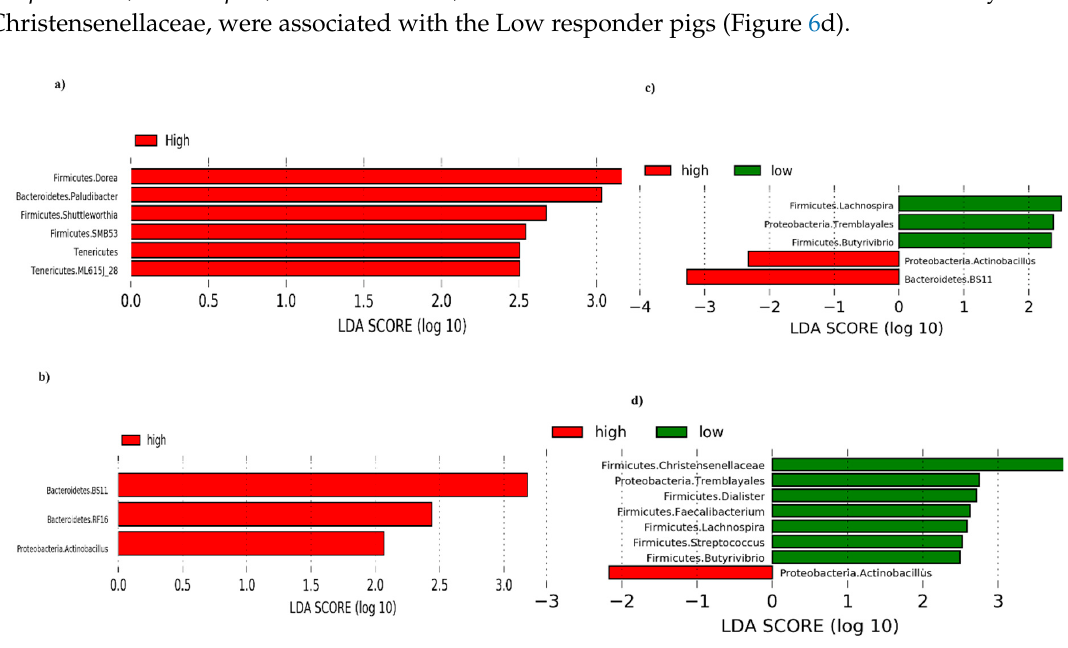
Figure 6. Discriminant analysis of pre-vaccination taxa (at genus level) in High and Low responder pigs selected based on antibody titers determined at different time points. ( a ) Taxa that significantly discriminated between High and Low responder pigs selected based on antibody titers determined at 21 dpv. ( b ) Taxa that significantly discriminated between High and Low responder pigs selected based on antibody titers determined at 28 dpv. ( c ) Taxa that significantly discriminated between High and Low responder pigs selected based on antibody titers determined at 35 dpv. ( d ) Taxa that significantly discriminated between High and Low responder pigs selected based on antibody titers determined at 118 dpv. dpv = days post-vaccination. 3.4. Contrasted Antibody Response Was Not Accompanied by Significant Changes in Microbiota Composition at 21, 35, and 118 dpv No significant differences were observed between the High and Low responder pigs at 21, 35, and 118 dpv except, we found eight OTUs that were differentially abundant between the two groups at 21 dpv. Four of the differentially abundant OTUs were annotated to Prevotella , three were annotated to Treponema , and one was annotated to unclassified Bacteroidales. Of the eight OTUs, only one OTU annotated to Prevotella was abundant in the group of pigs classified as High, whereas the rest were abundant in the Low responder pigs. No other significant differences were observed. 4. Discussion The gut microbiota plays an important role in shaping mucosal and systemic immunity and protecting the host from pathogen expansion and invasion [5,6]. In this study, we used M. hyopneumoniae vaccination to study the potential of early gut microbiota at weaning in predicting future vaccine response, and to explore the dynamics of gut microbiota composition following vaccination. Previous studies in both human and mouse models have demonstrated the importance of commensal bacteria in immune responsiveness to infections in various ways, and to vaccines, such as influenza, polio, and cholera toxins [10,17,38,39]. The studies also suggested that colonization by specific bacteria and reduced dysbiosis in early infancy may improve vaccine responses later in life, whereas other bacteria may lower vaccine response [18,40]. The current study revealed that OTUs annotated to Prevotella , [ Prevotella ], Anaerovibrio , and Sutterella , best-predicted antibody levels at later time points post-vaccination, an observation that was also reflected at the genus level. However, as observed in our previous study [22], the current results showed that differences in vaccination response did not translate to global changes in the